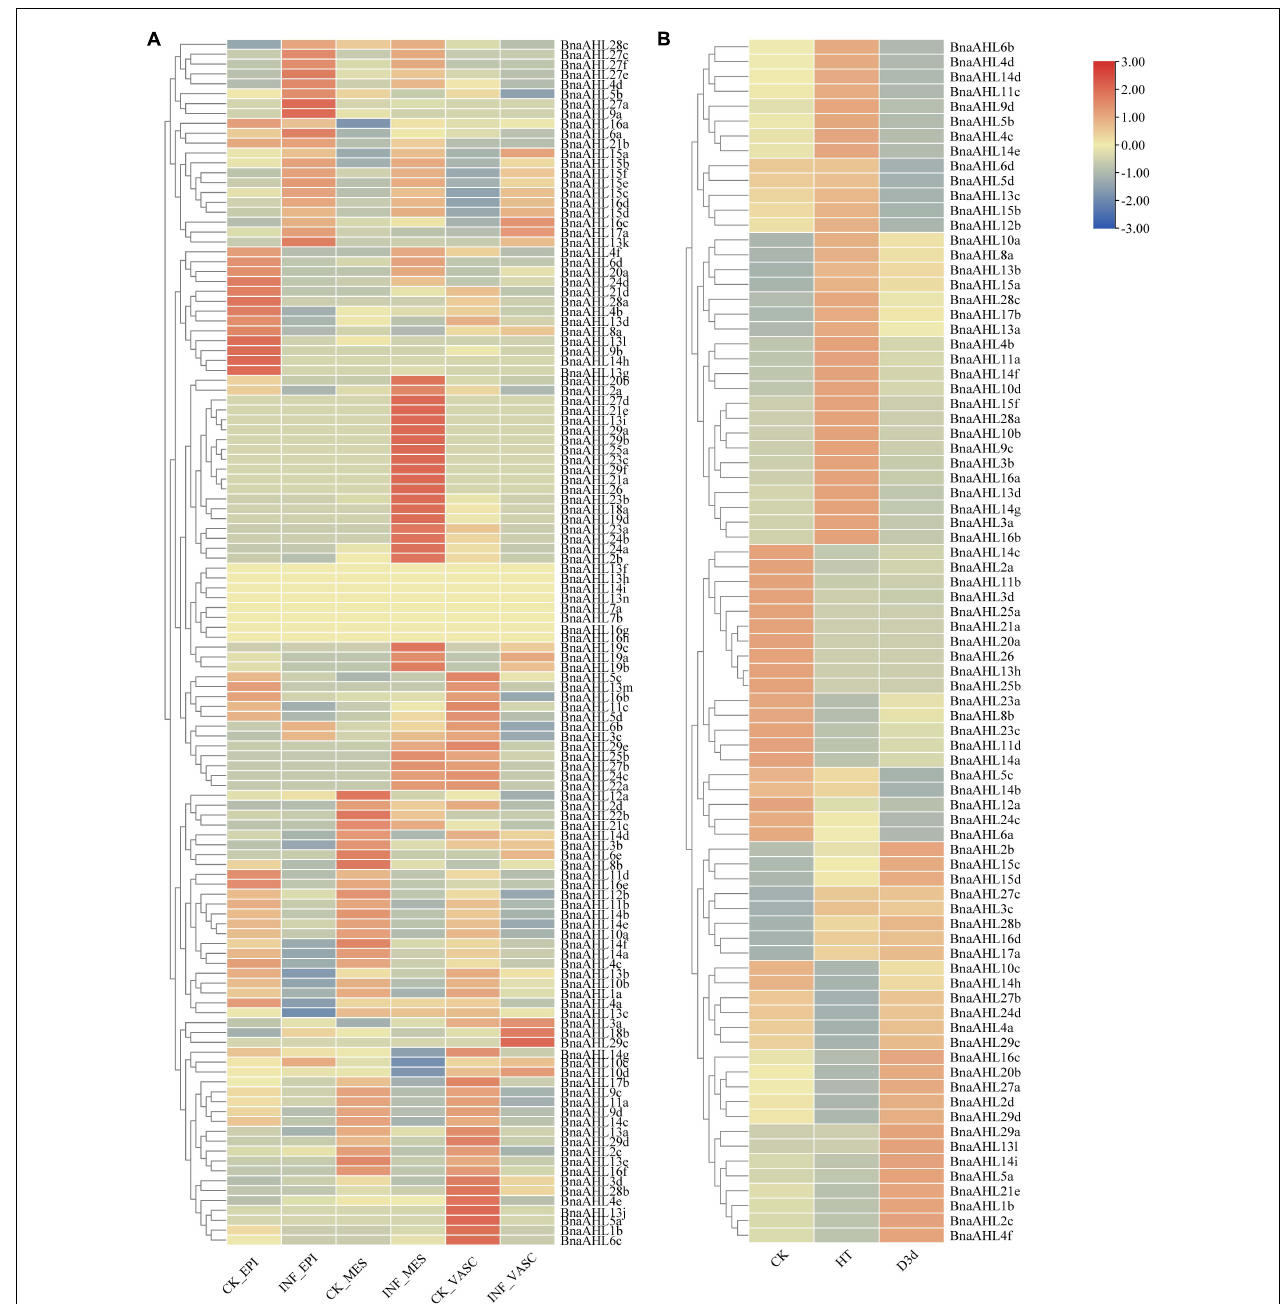
FIGURE 8 | Expression patterns of BnaAHLs under infection by S. sclerotiorum (A) and under abiotic stresses (B) . BnaAHLs are clustered by hierarchical clustering. The TPM (Transcripts Per Million) method was used to normalize gene expression. The legend label is shown on the right side of the figure. Genes with high expression levels are shown in red, and genes with low expression levels are shown in blue. CK is control check, INF is the sample infected with S. sclerotiorum , EPI, MES, and VASC is epidermis, mesophyll and vascular, respectively. HT and D3d represent the expression of B. napus under heat treatment and drought treatment after 3 days,